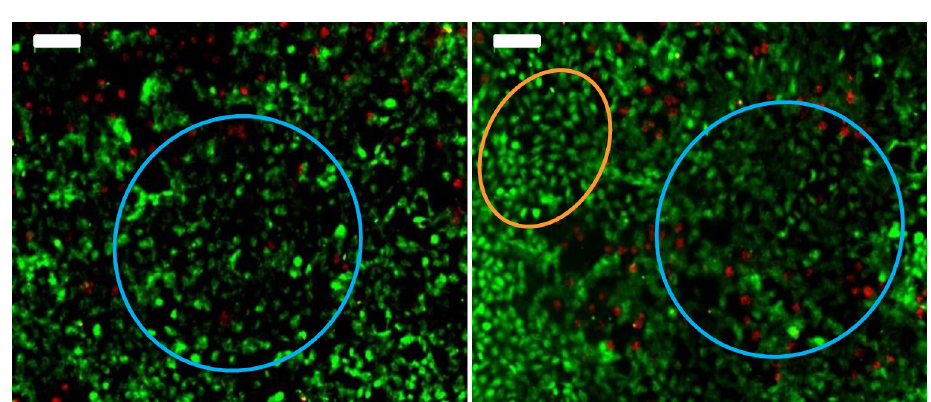
Fig 6. Epi-fluorescence microscopy images of Vero cells on CNT-coated carbon electrodes (scale bar: 100 μ m). Reactors were inoculated with 30 000 cells. After 72 hours of incubation electrodes were stained with Syto9 1 (green, viable cells) and IP staining (red, damaged cells). Orange circle: Typical area with individualized cells. Blue circle: Area of aggregate cell layer with blurred boundaries between cells.